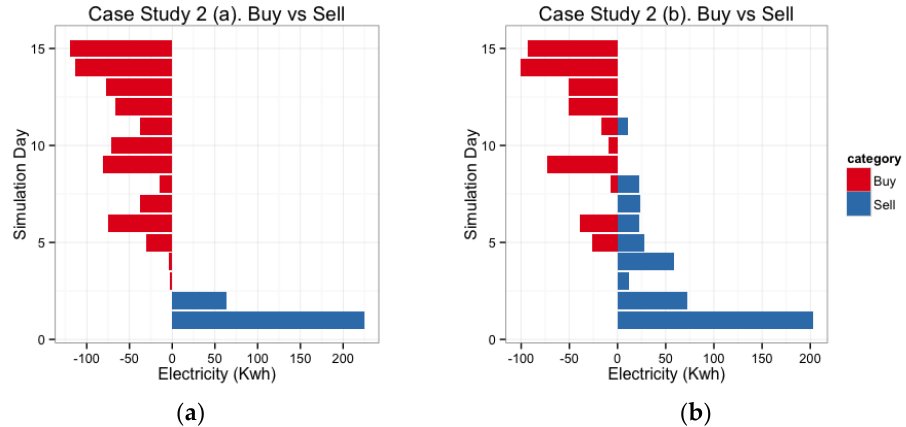
Figure 6. Case study 2: Electricity purchased vs. electricity sold in scenarios ( a , b ). The diagram on the right shows the increase in selling events with respect to the scenario ( a ).